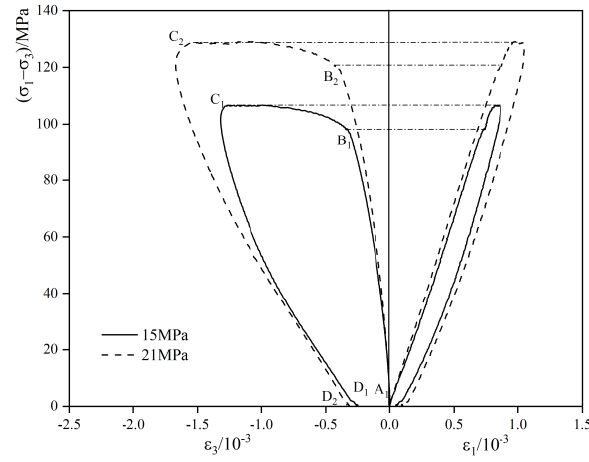
Figure 3. Unloading stress − strain curve.